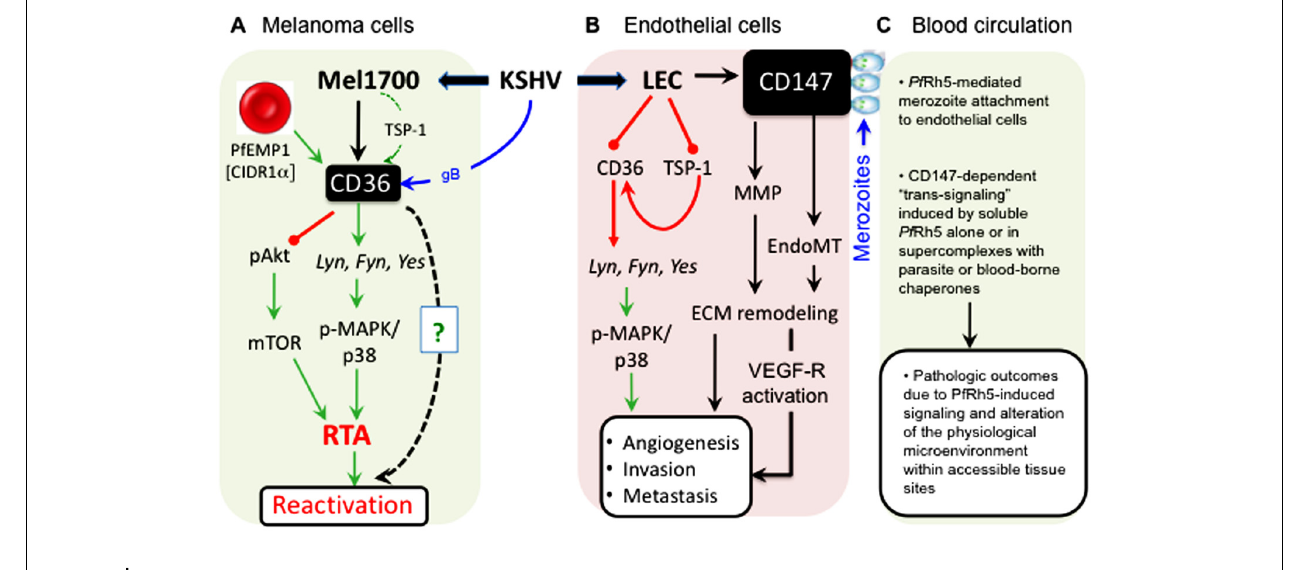
KSHV upregulates CD147 but unlike in Melanoma cells, the virus downregulates both CD36 and its angiostatic ligand,TSP-1; in vivo , these effects are likely to promote angiogenesis, invasion, and tumor metastasis. (C) As a key receptor for the merozoite invasion antigen, Pf Rh5, KSHV-induced upregulation of CD147 on the surface of infected endothelial cells increases the frequency of contacts between merozoite-bound or soluble Pf Rh5 and blood or dermal microvascular endothelial surfaces, resulting in induction of CD147-mediated signals that could alter the microenvironment and cause pathologic outcomes in a variety of physiological sites in the co-infected